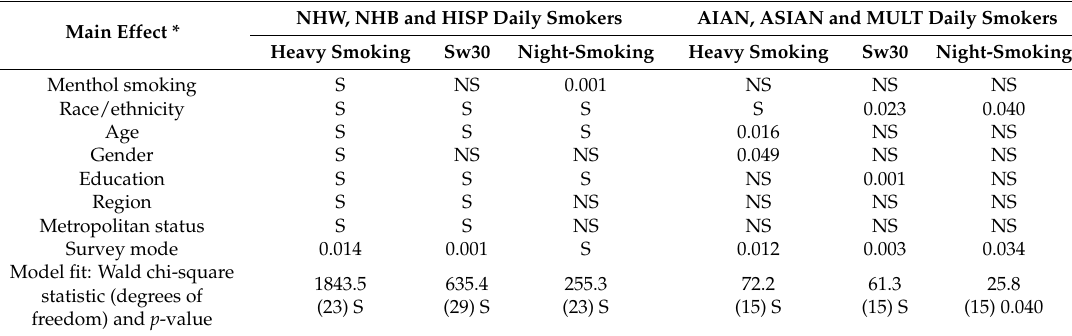
Table 4. Results of multiple logistic regressions: main effects and p